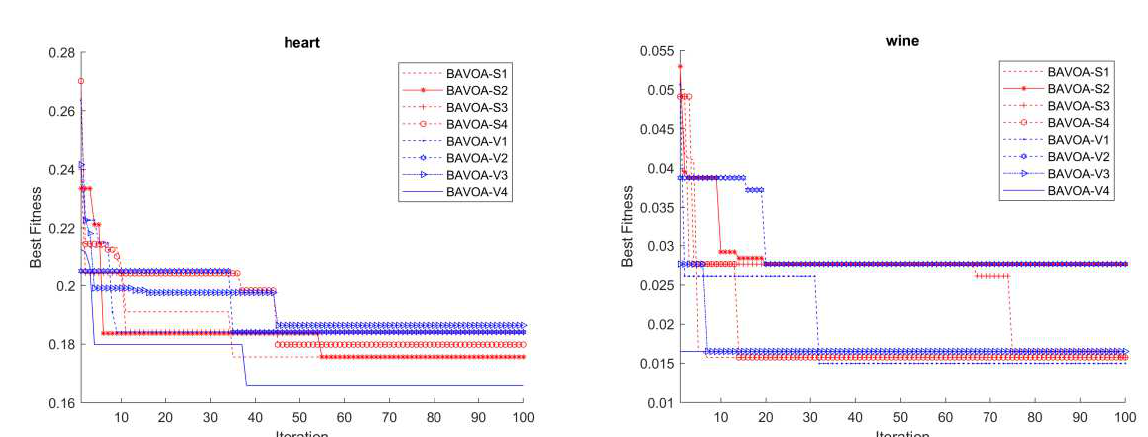
Figure 10. Comparison of the convergence of S-shaped- and V-shaped-based methods on the first six sets .